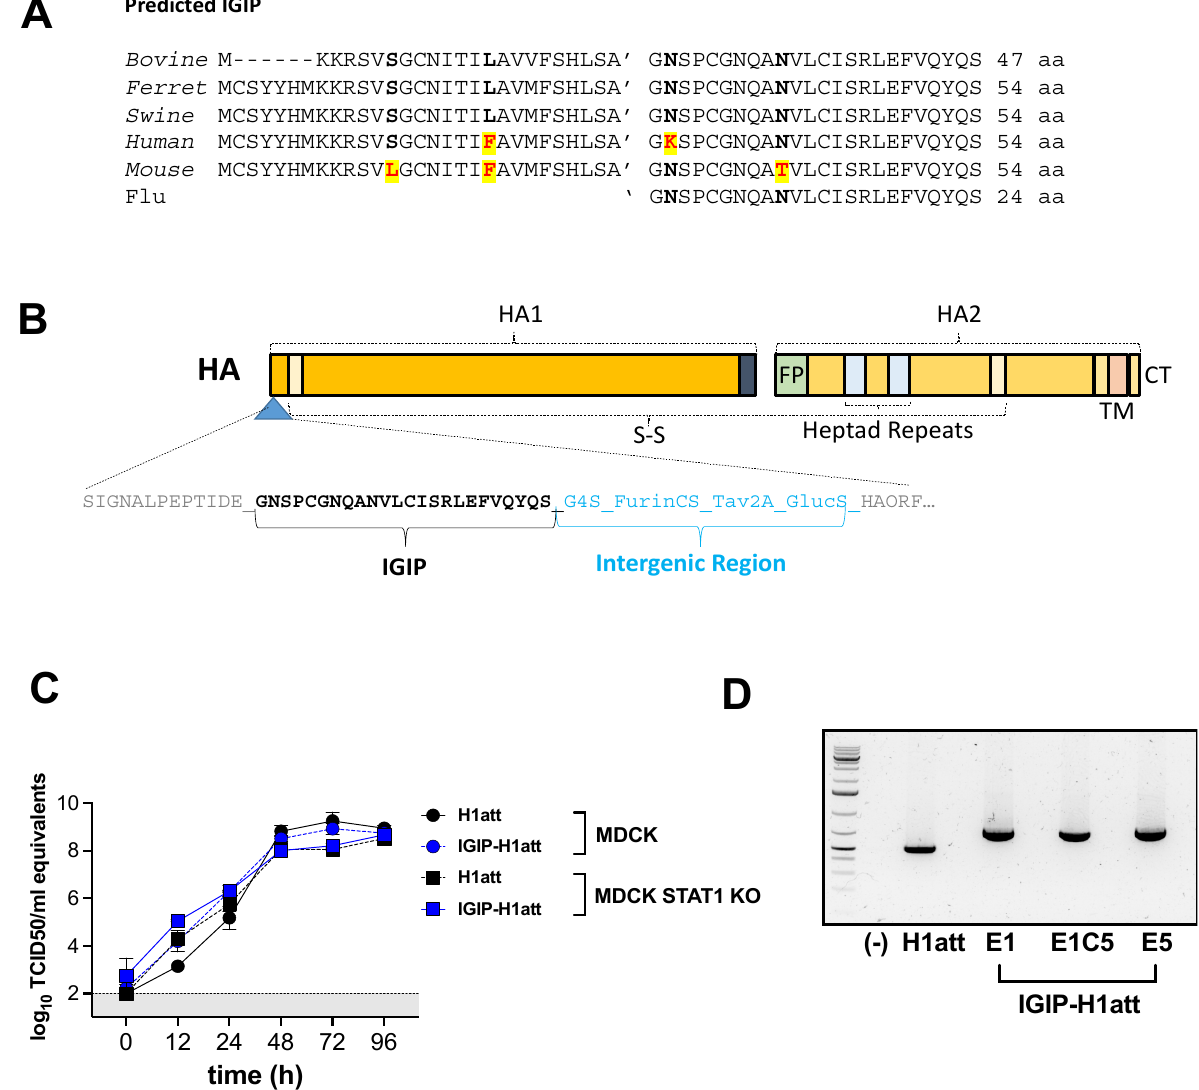
Figure 1. In vitro growth kinetics. ( A ) Alignment of the predicted IGIP in different mammalian species. The mature swine IGIP sequence used in this study is shown. ( B ) Schematic representation of the IGIP-H1 gene. The IGIP sequence and the components of the intergenic region are indicated. ( C ) Growth kinetics profiles of IGIP-H1att and H1att in MDCK and MDCK STAT1 KO cells. Experiments were performed two times independently, each time in triplicate. Titers were determined by RT-qPCR and expressed as log 10 TCID50 equivalents. Gray area represents the area below the level of detection of the assay. ( D ) IGIP-H1att virus was serially passaged five times in MDCK (E1C5) cells and SPF eggs (E5), and the HA was amplified by RT-PCR, showing that the IGIP-H1 rearrangement is stable. Abbreviations: FP, fusion peptide; TM, transmembrane domain; CT, c-terminal region; G4S, poly-glycine protein linker; Furin CS, furin cleavage site; Tav2A, Thosea assigna virus 2A protein sequence; GlucS, Signal peptide of Gaussia luciferase.